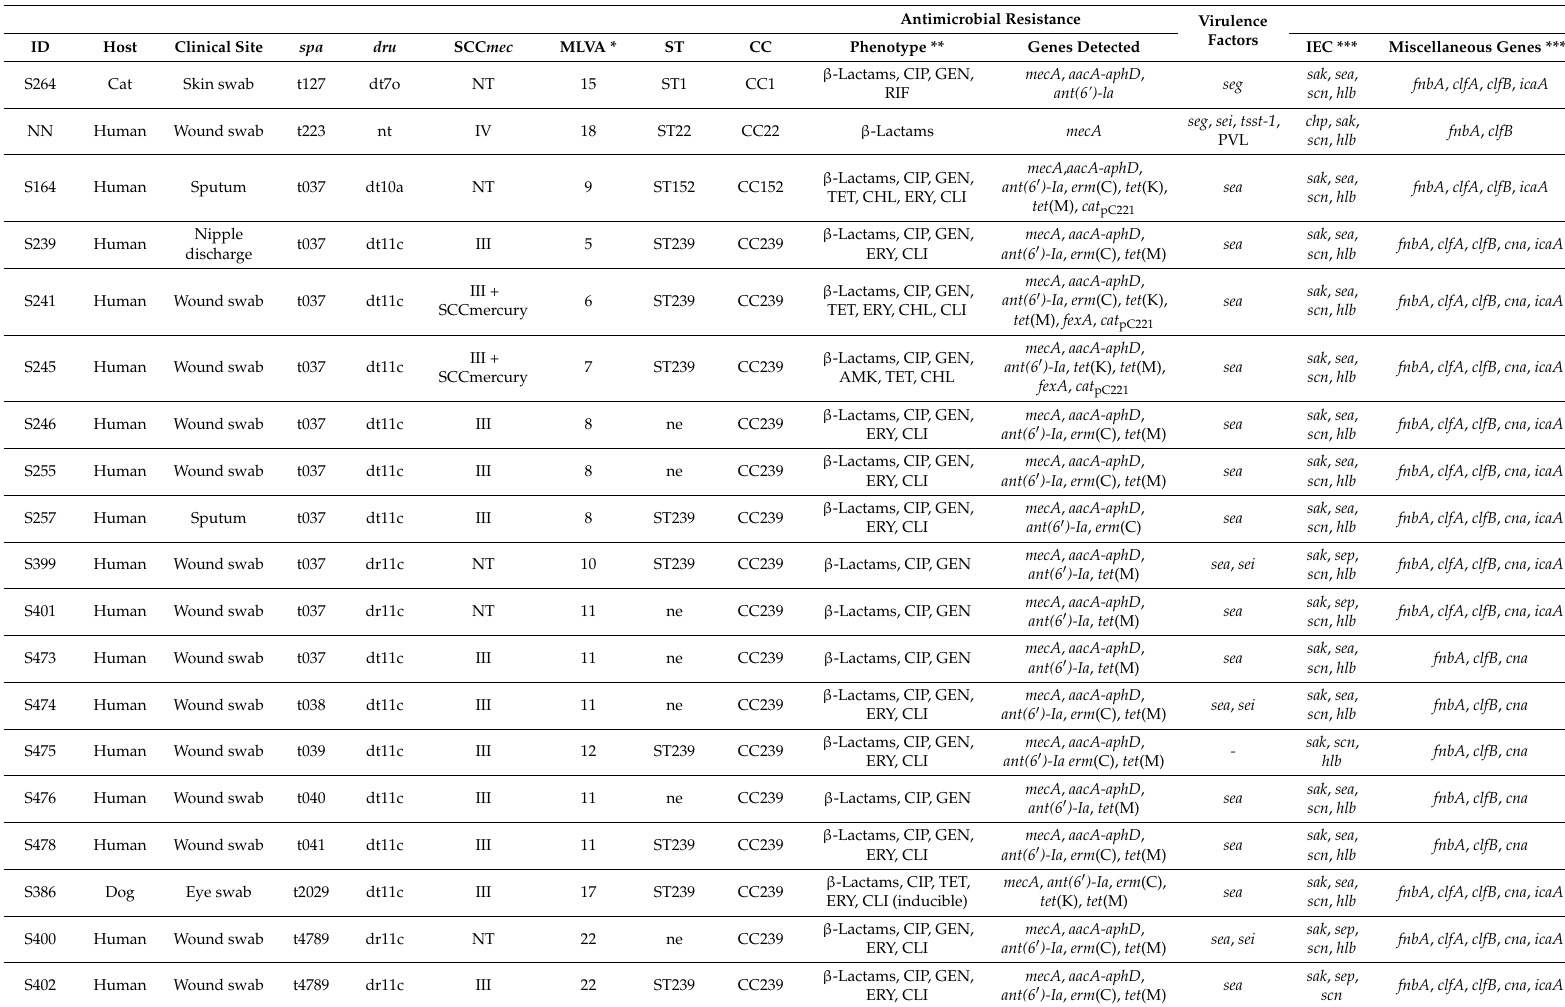
Table 1. Molecular characterization, antimicrobial resistance, and toxin profile of the methicillin-resistant Staphylococcus aureus isolates